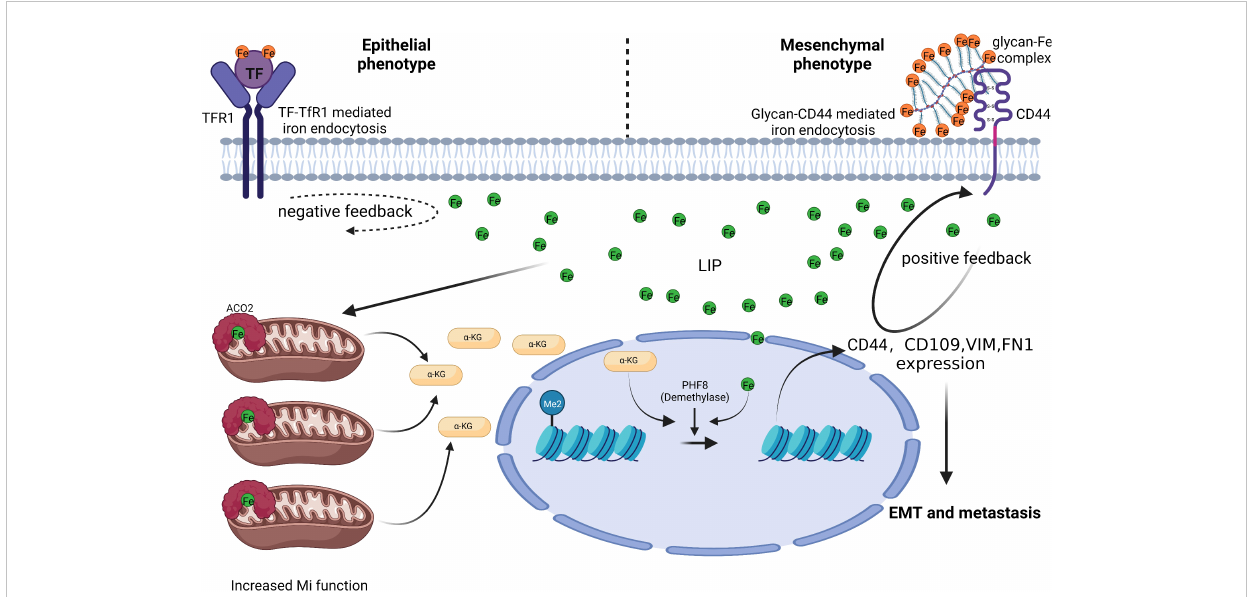
FIGURE 1 CD44 mediates iron absorption when CRC cells undergo EMT. CRC cells with an epithelial phenotype import iron via the TF-TfR1 mechanism. CRC cells with a mesenchymal phenotype need more iron, but the TF-TfR1 mechanism is limited by negative feedback between intracellular iron and TfR1. Glycan-Fe(III)-CD44 mediated iron absorption can aid CRC cells in sequestering iron and improve mitochondrial function and a -ketoglutaric acid( a -KG) production. Increased a -KG cooperates with ferrous iron to boost the plant homeodomain fi nger protein 8 demethylase activity. Ultimately, this causes EMT associated genes (including CD44 ) expression (58). Thus, positive feedback is formed between intracellular iron and CD44 to satisfy the higher iron need of mesenchymal phenotype CRC cells and facilitate CRC